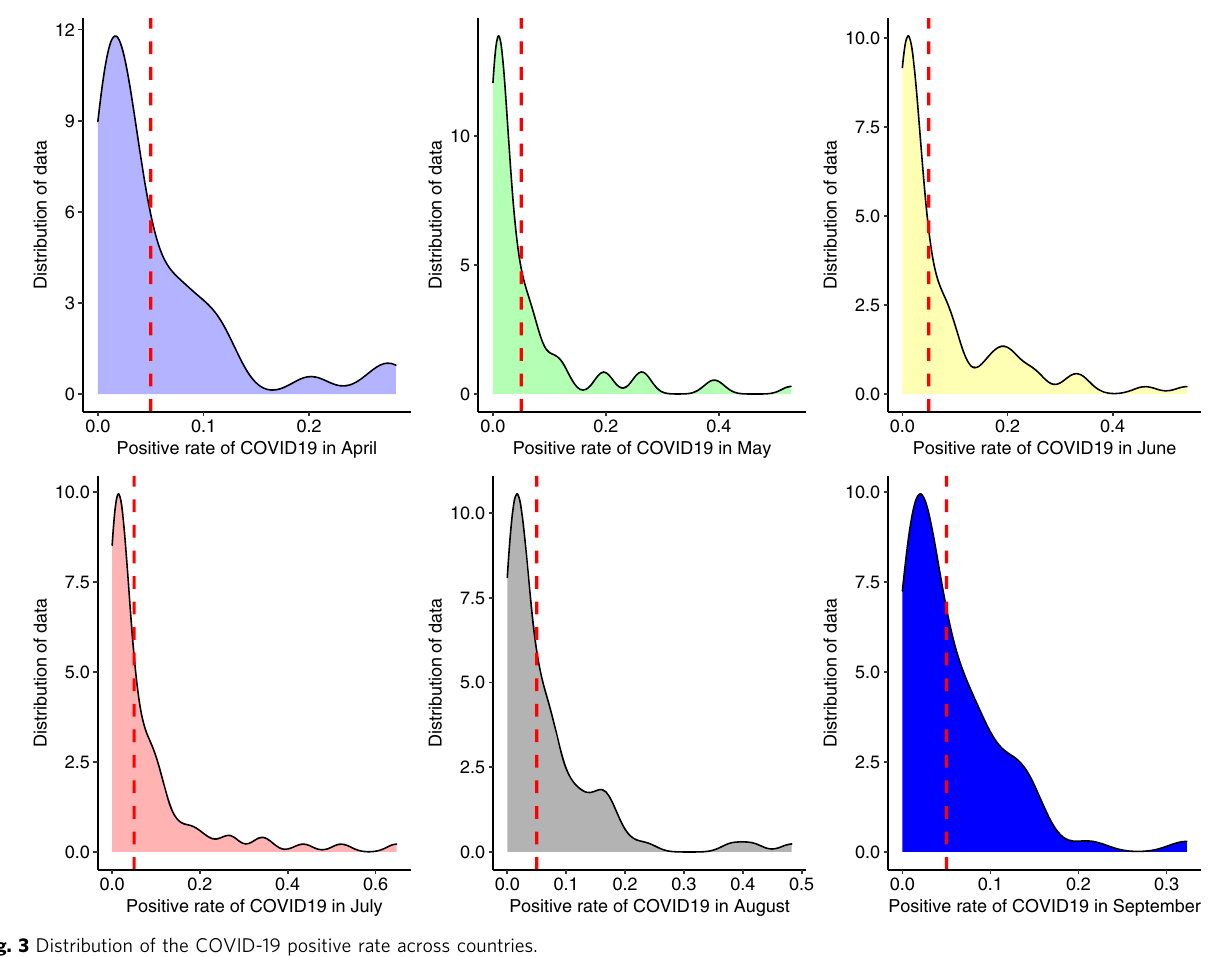
Fig. 3 Distribution of the COVID-19 positive rate across countries.